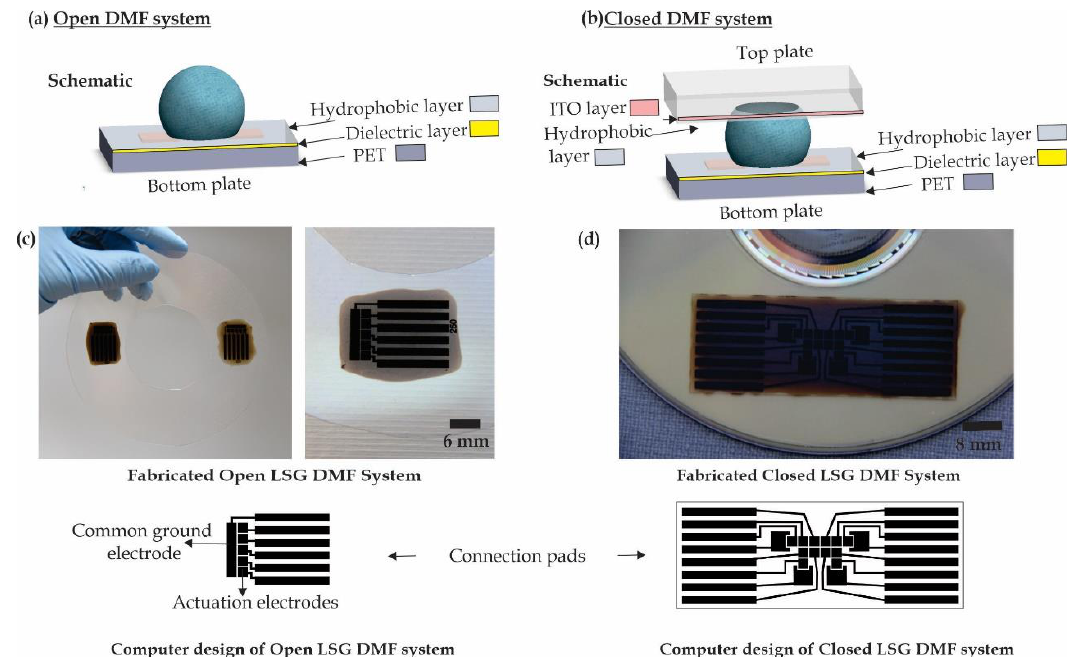
Figure 1. ( a ) Single-plate (open) digital microfluidic system versus ( b ) parallel-plate (closed) digital microfluidic system. ( c ) Two fabricated open-system digital microfluidic (DMF) chips printed with a long electrode acting as a common ground and five discrete electrodes for droplet manipulation. ( d ) A closed system with 12 electrodes and four reservoirs.